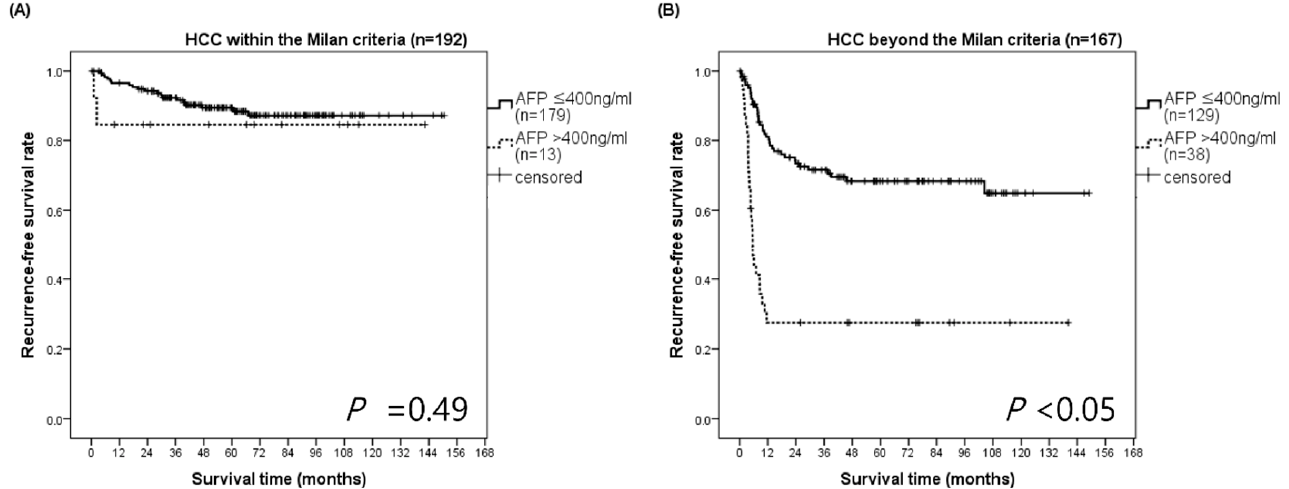
Figure 3. Recurrence-free survival according to the Milan criteria in the subgroups stratified by AFP. ( A ) In the WM group, HCC recurrence-free survival rates at 1, 3, and 5 years for patients with AFP ≤ 400 ng/mL were 96.6%, 92.4%, and 89.4%, respectively, whereas those for patients with AFP > 400 ng/mL were 84.6%, 84.6%, and 84.6%, respectively ( p = 0.49). ( B ) In the BM group, HCC recurrence-free survival rates at 1, 3, and 5 years for patients with AFP ≤ 400 ng/mL were 81.1%, 71.6%, and 68.4%, respectively, while those for patients with AFP > 400 ng/mL were 27.5%, 27.5%, and 27.5%, respectively ( p < 0.05). BM, beyond the Milan criteria; HCC, hepatocellular carcinoma; WM, within the Milan criteria.